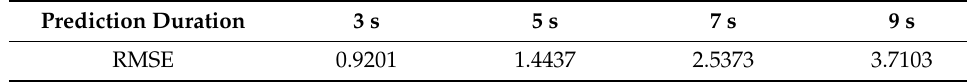
Figure 11. Single − step prediction effect and error of prediction model under UDDS cycle. Table 3. Prediction errors of different prediction durations.